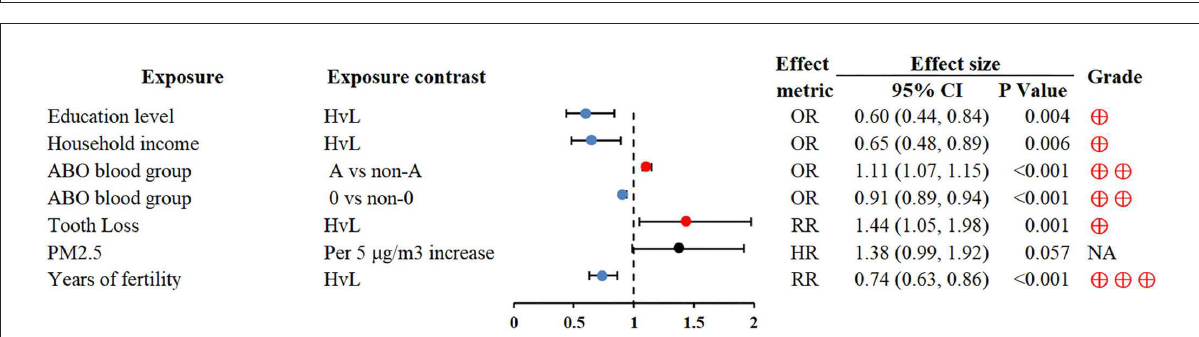
lupus erythematosus, pernicious anemia and diabetes mellitus, type 1) were closely associated with an increased risk of GC (RR 1.34; 1.05–1.72; RR 2.84; 2.30–3.50; RR 1.41; 1.2–1.67, respectively) (81, 83) (Figure